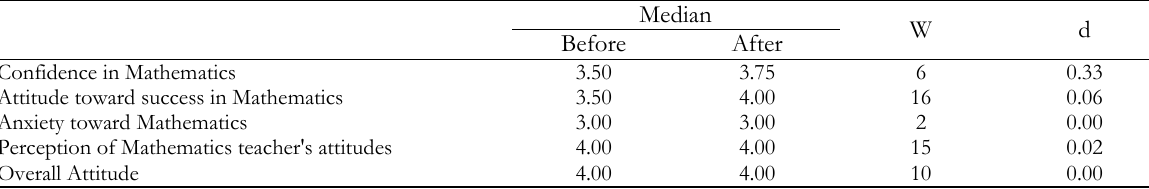
Table 5. Attitude test result of the experimental group